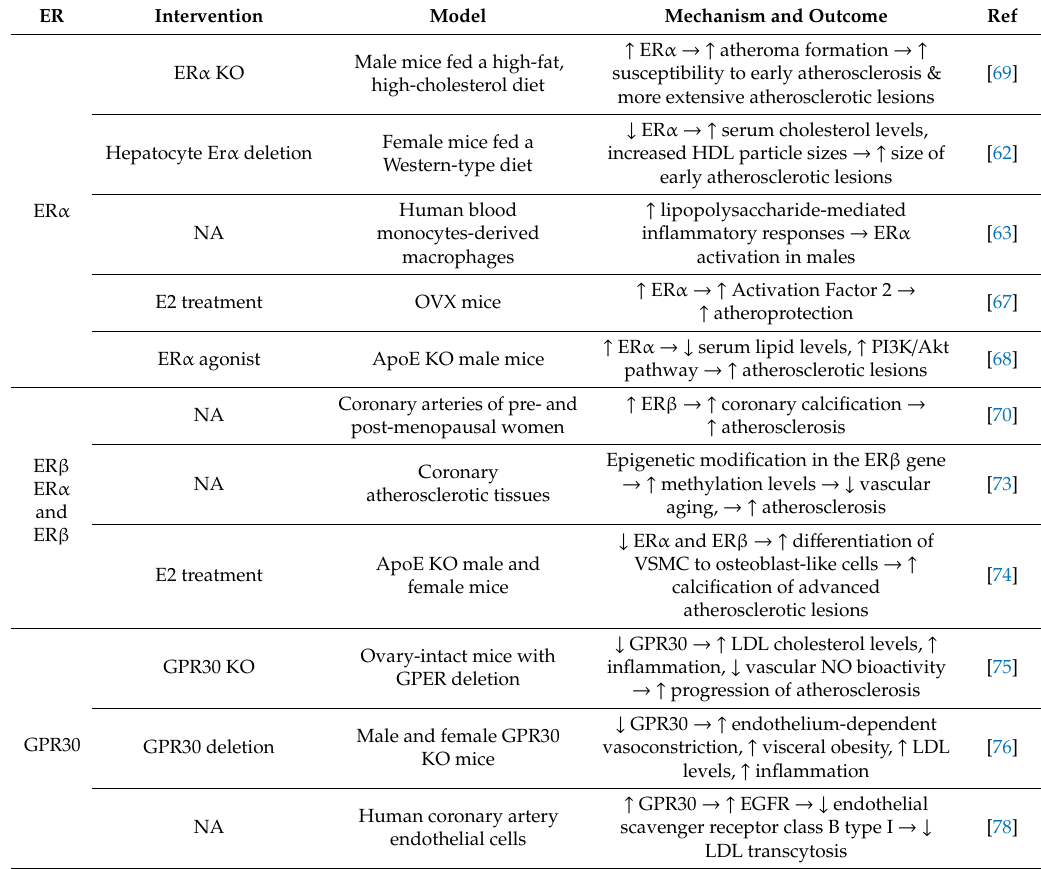
Table 3. Role of estrogen receptors in